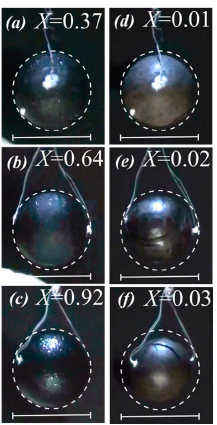
Figure 7. Sample surface: ( a ) initial; ( b ) final states in Test 1; ( c ) initial; ( d ) final states in Test 2; ( e ) initial; and ( f ) final states in Test 3.